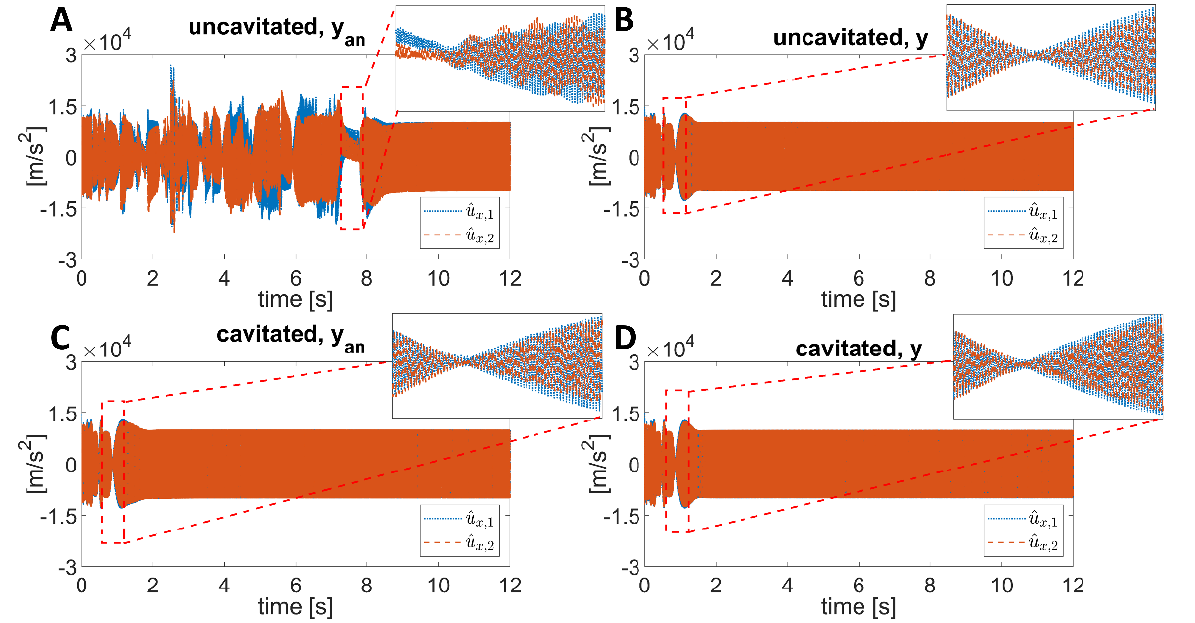
are reported for uncavitated and 𝑑𝑑̃̈ 𝑒𝑒𝑖𝑖 ( 𝑠𝑠 , 𝜔𝜔 )